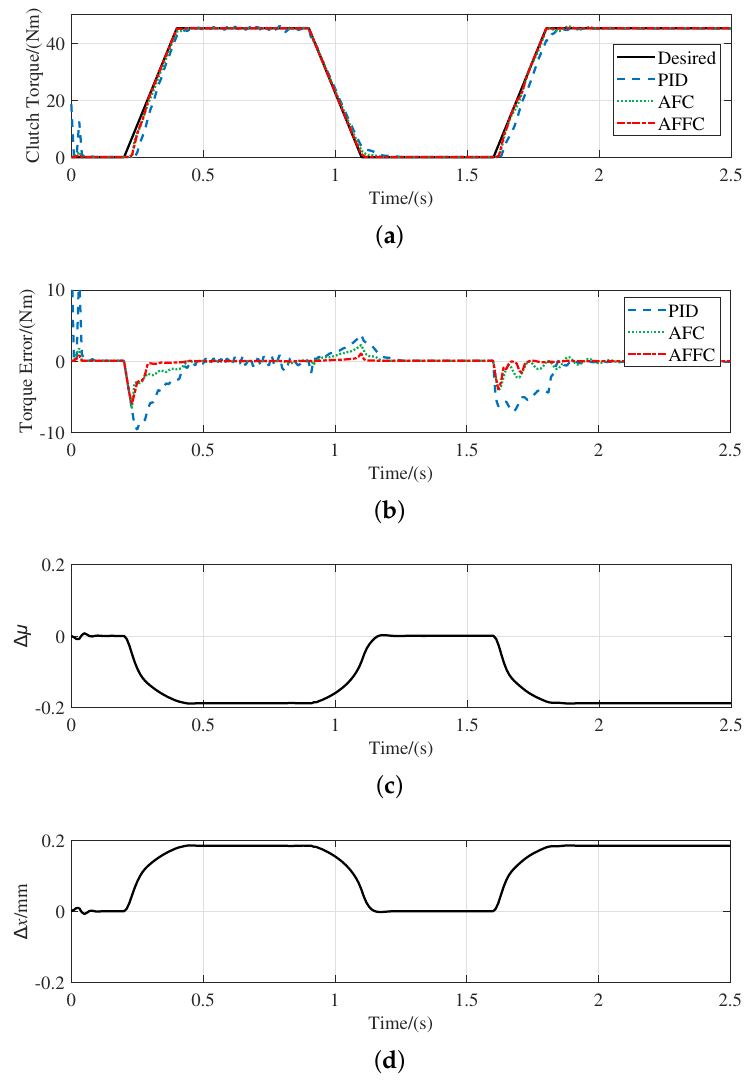
Figure 12. Performance comparison of torque loop controllers under the third simulation condition: ( a ) Clutch Torque; ( b ) Torque Error; ( c ) Friction Coefficient Uncertainty; ( d ) Translation